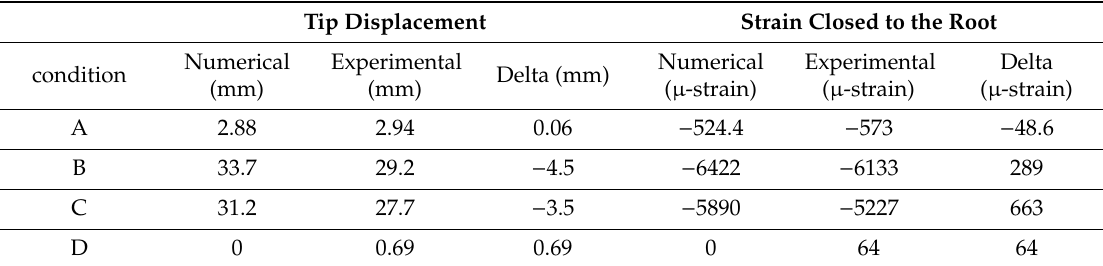
Table 3. Numerical (non-linear) vs. experimental results.